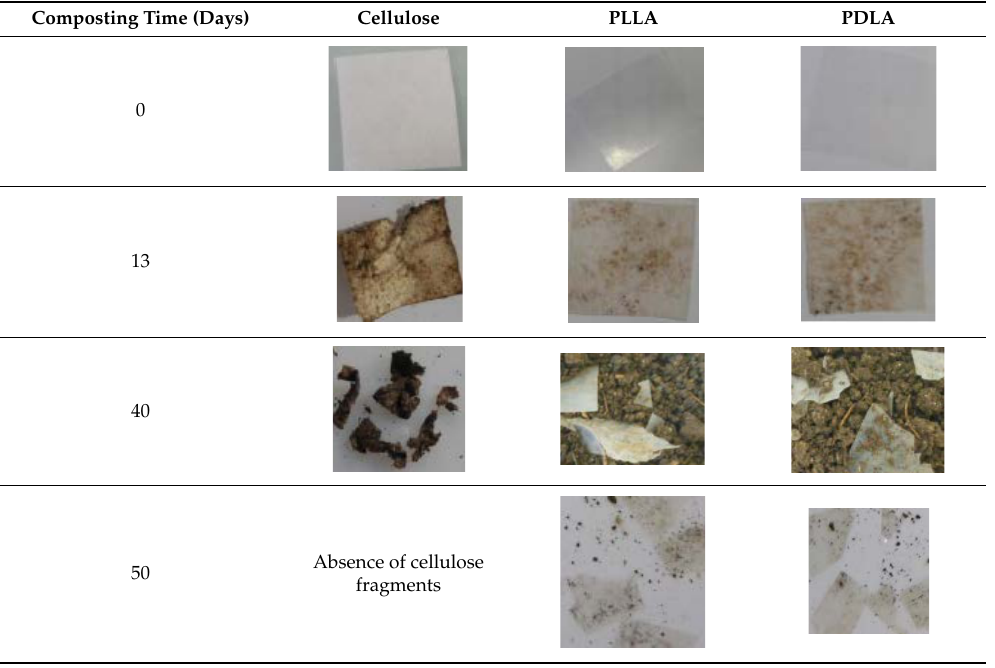
Table 2. Visual evolution of cellulose and polymer fragments.